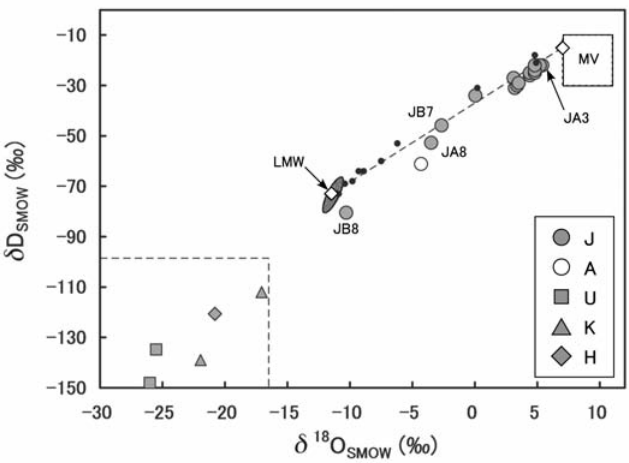
Figure 4. The δ D and δ 18 O values of water in the fumarolic gases and hot spring waters. Square, upper right, general range of the values for the typical MV of an andesitic volcano above a subduction zone. Elliptical region, local meteoric water (LMW) at the summit area of Iwate volcano [Kazahaya et al. 2000]. Small filled dots, isotope ratios of the hot spring water. Dashed horizontal and vertical lines, bottom left, δ D and δ 18 O, respectively, of the water vapor equilibrated with the LMW at 100